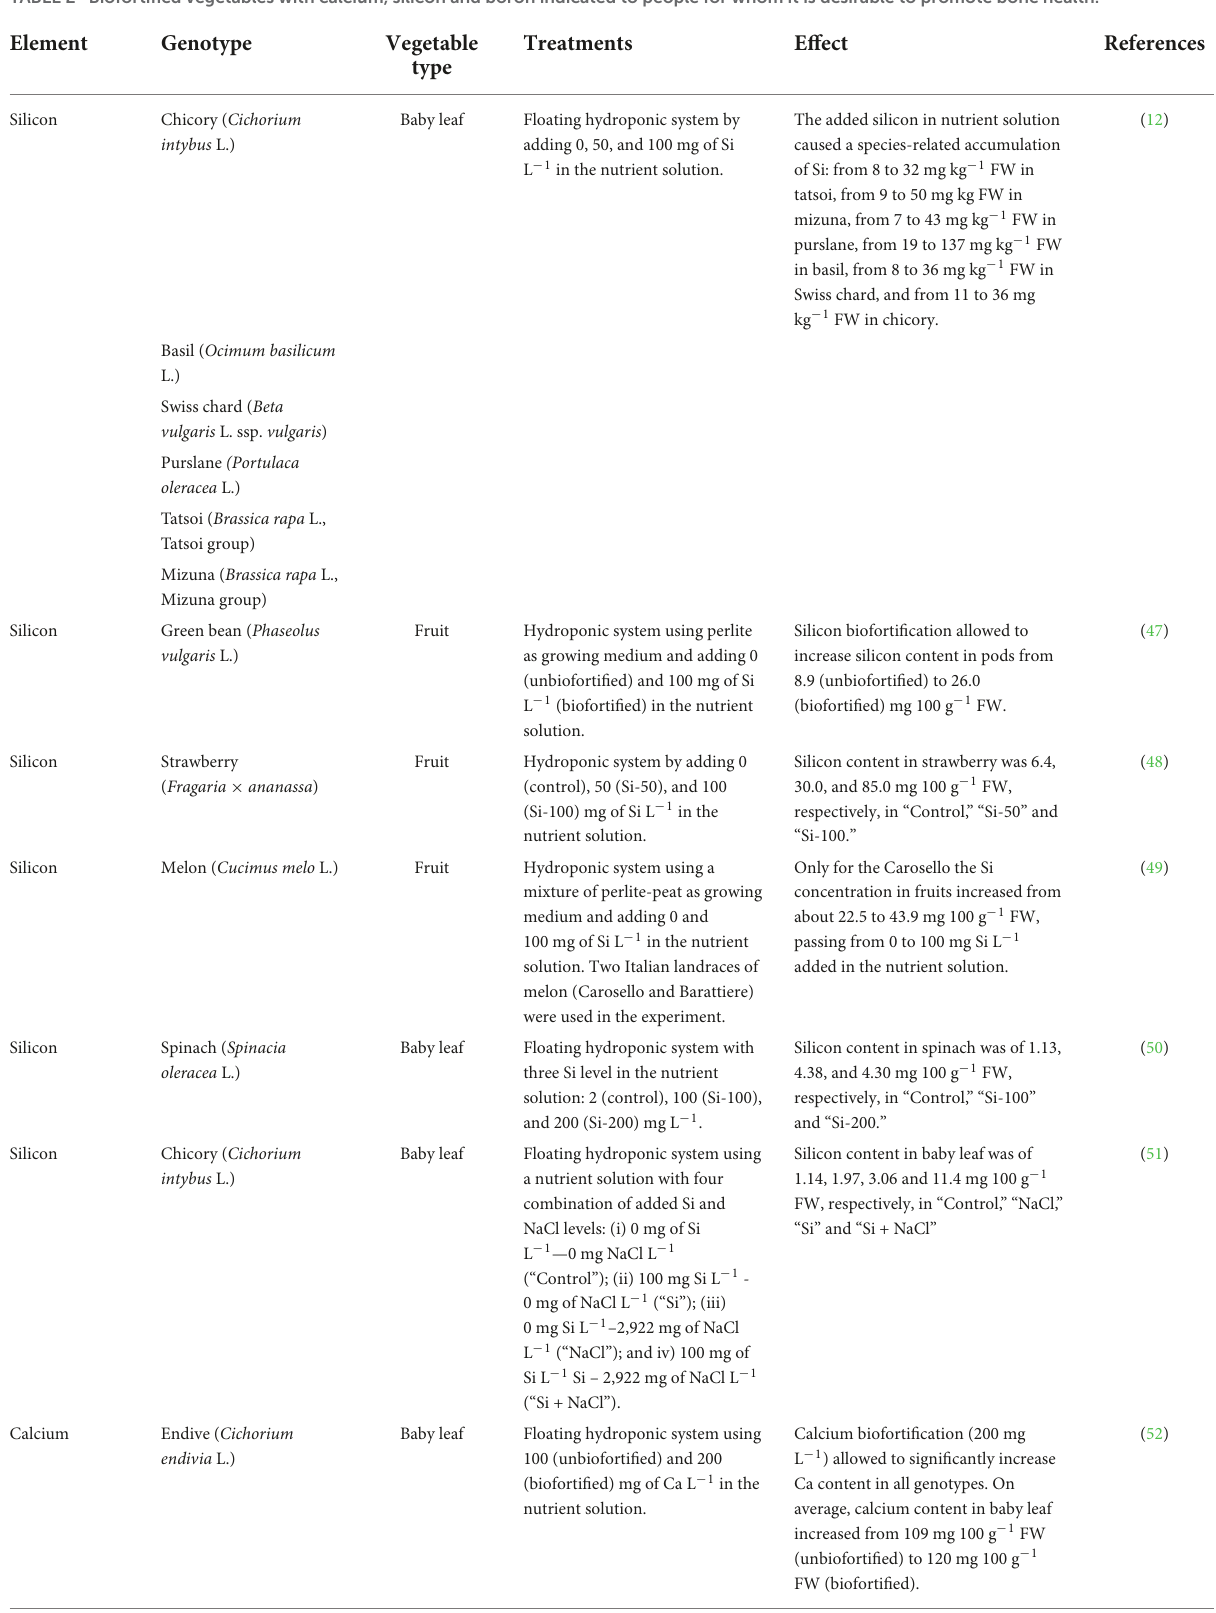
TABLE 2 Biofortified vegetables with calcium, silicon and boron indicated to people for whom it is desirable to promote bone health.